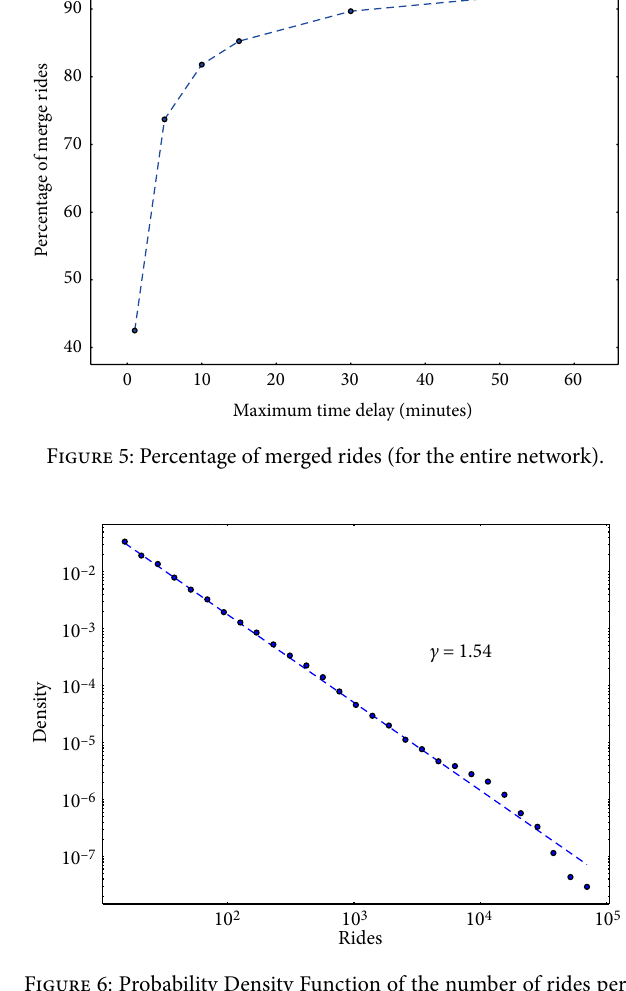
Figure 6: Probability Density Function of the number of rides per